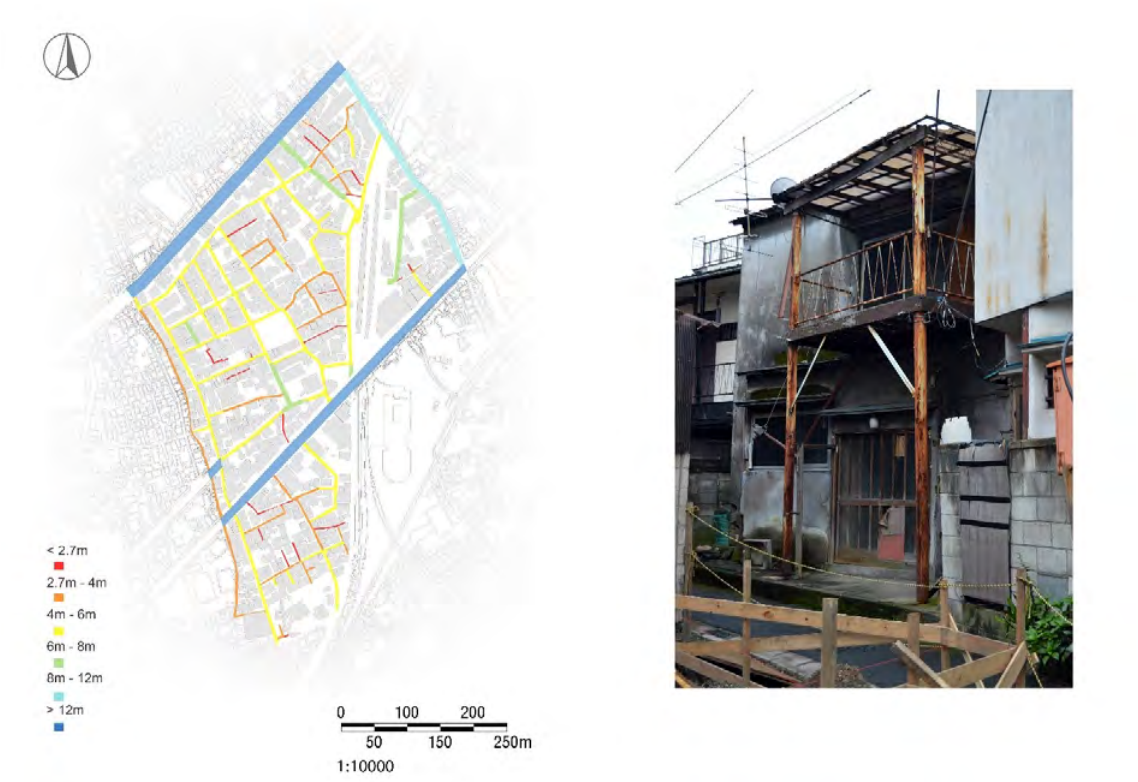
Figure 4. (a) Road width plan. (b) Vacant house. Photo by